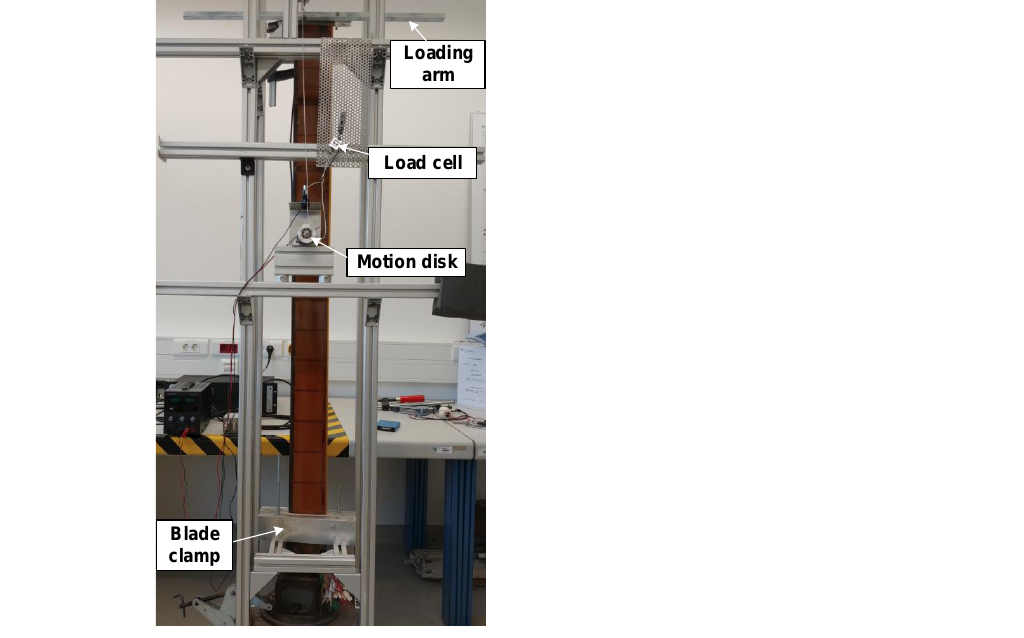
Figure 11. STAR blade in the lab bench test for elastic property evaluation.